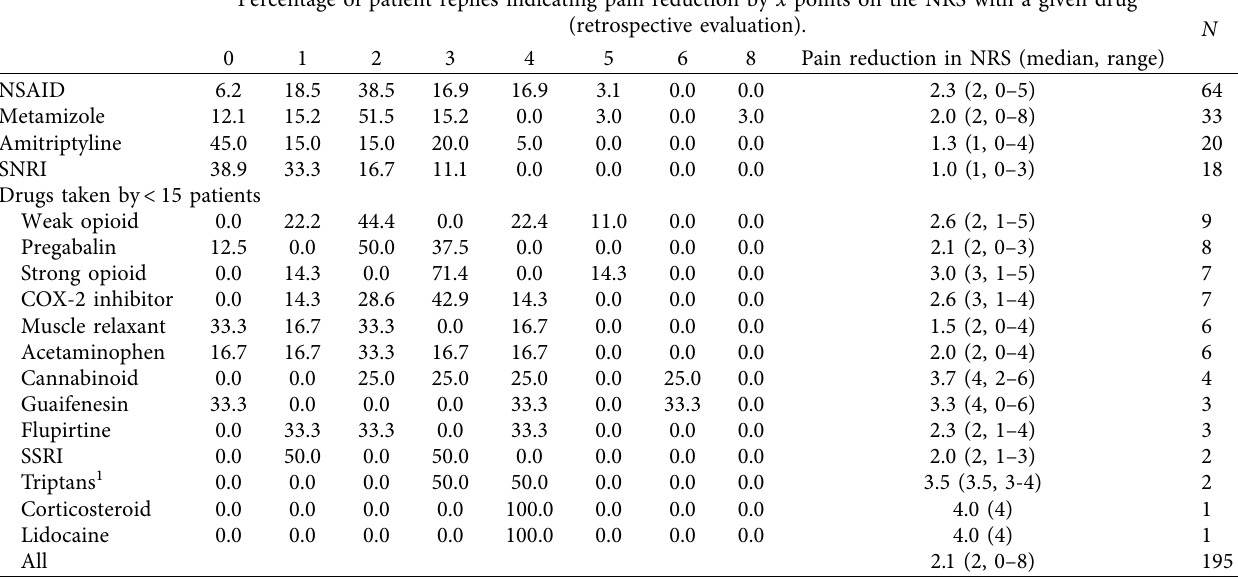
Table 3: Effect of the medication on pain relief.